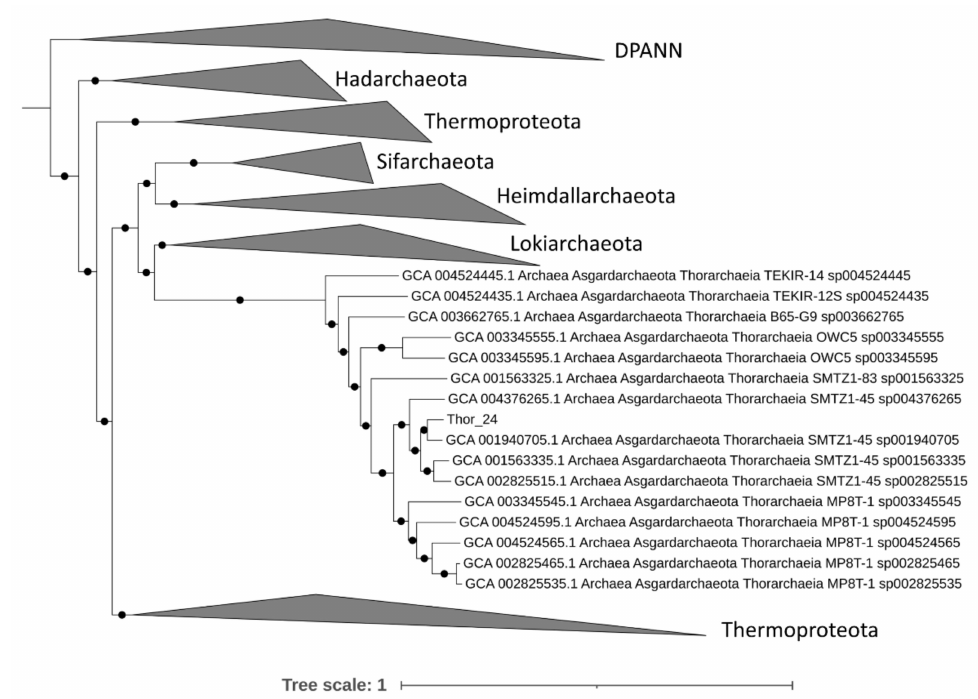
Figure 1. Phylogenomic analysis of Thorarchaeota metagenome-assembled genome (MAG) (Thor_24) based on 76 archaeal phylogenetic markers using IQTree. Only nodes supporting a bootstrap value above 0.7 are shown. Diapherotrites, Parvarchaeota, Aenigmarchaeota, Nanoarchaeota and Nanohaloarchaeota (DPAAN) was manually placed as an outgroup. Taxonomy nomenclature from the GTDK database is displayed as well as the GenBank Accession